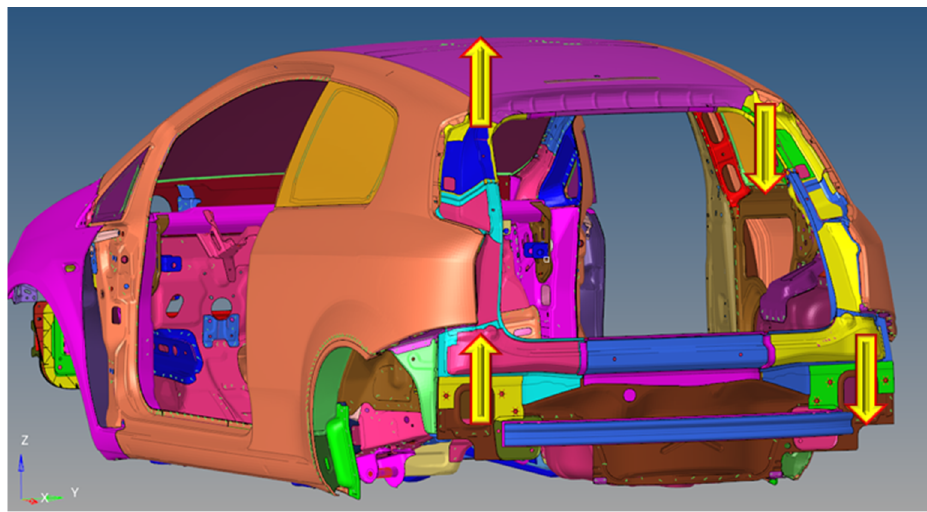
Figure 14. Highlight of the loaded points with a configuration of forces (yellow arrows) useful to simulate a twisting moment.